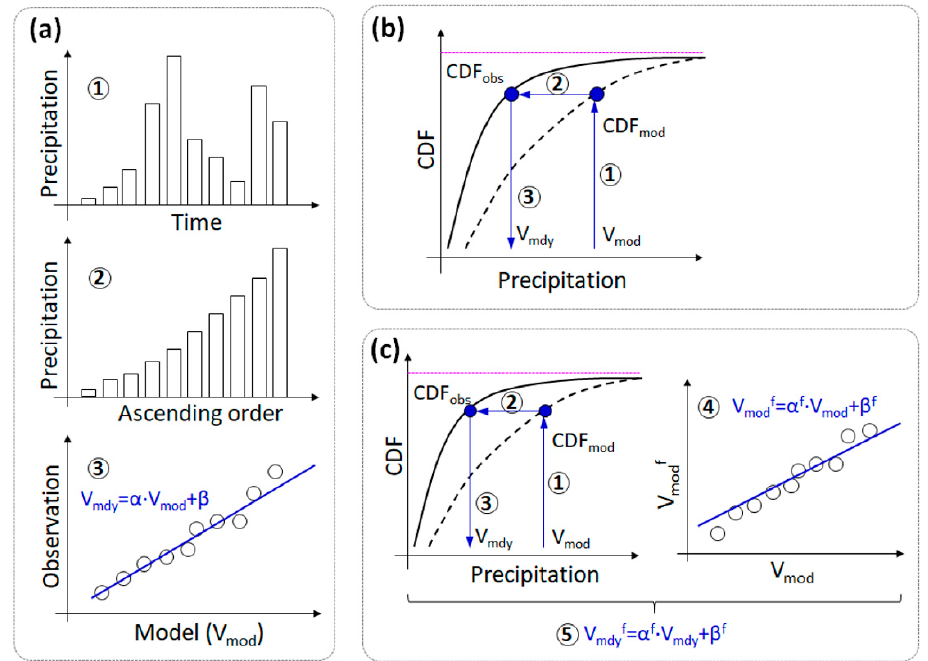
Figure A2. Schematic concepts of bias correction (BC). ( a ) Linear BC between the CNTL simulation and observation throughs steps 1 to 3 on data arrangement in ascending order; ( b ) Statistical BC through the same CDF searching between CTRL simulation and observation; and ( c ) combination of Linear BC and Statistical BC to obtain the future trend for PGW simulation. Note that V mod = model data, V mdy = modified data, f = future, and α , β = coefficients.